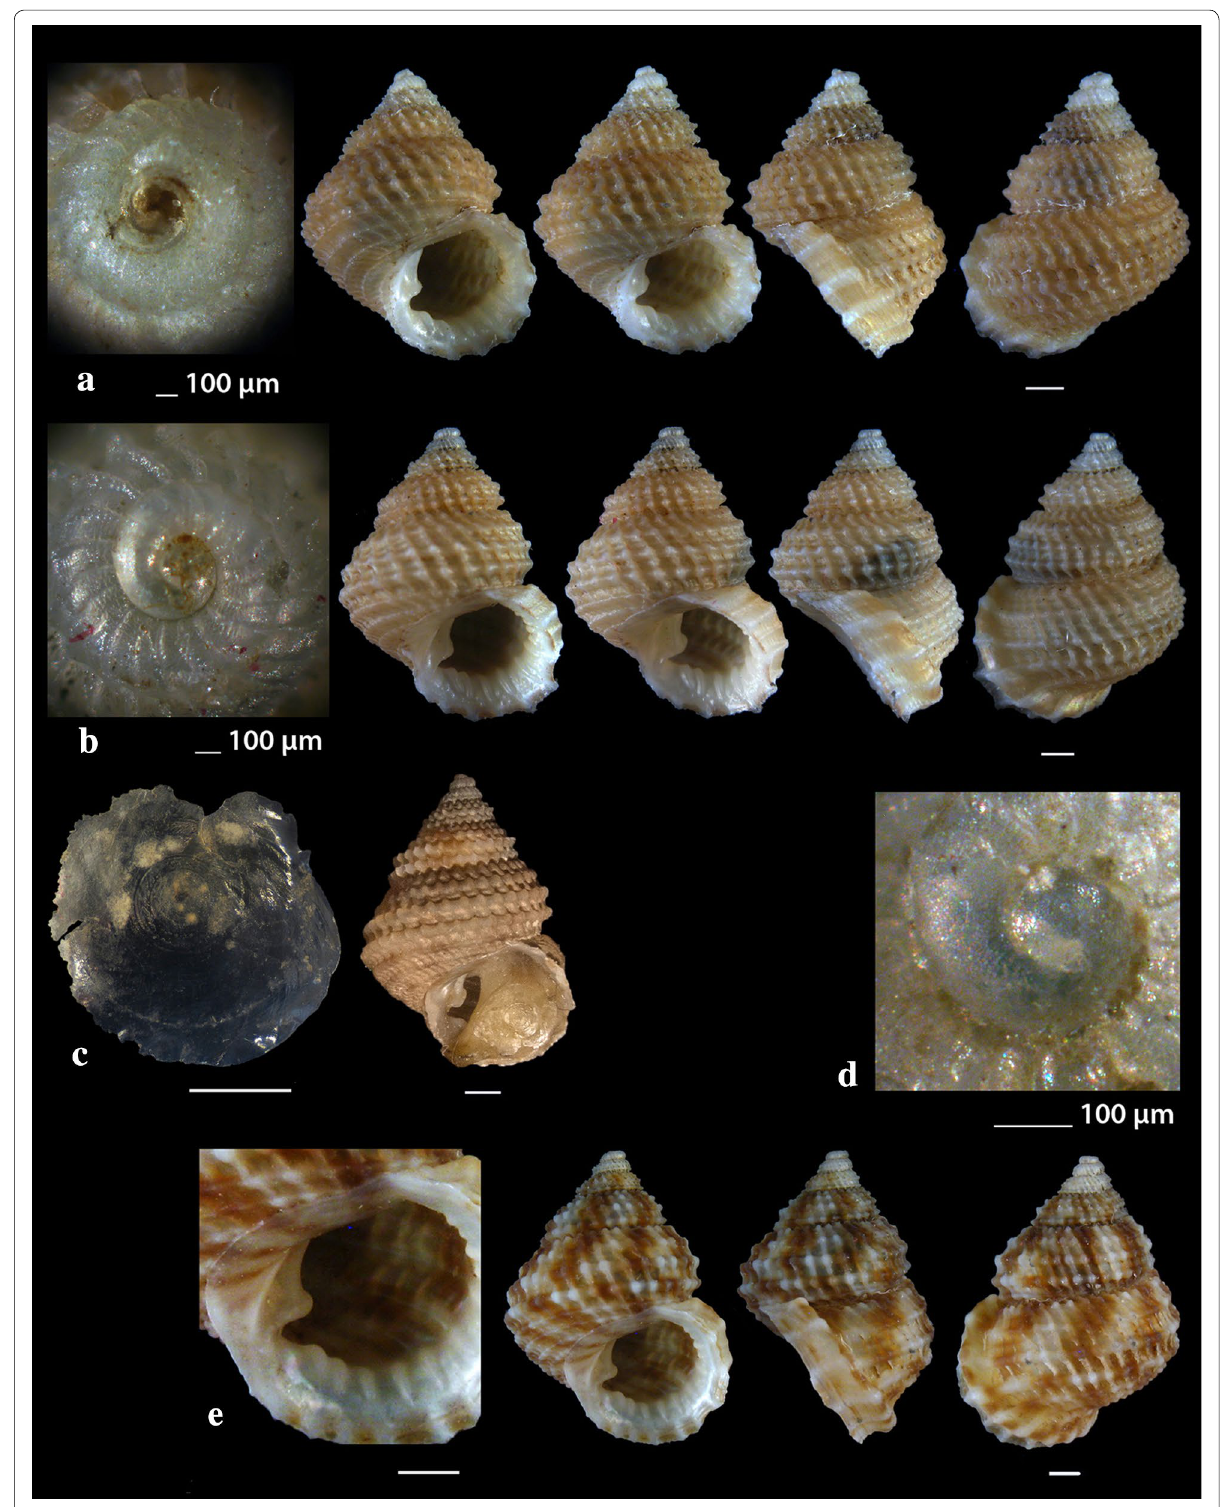
Fig. 5 a – c Danilia costellata , d – e Danilia tinei. Bar